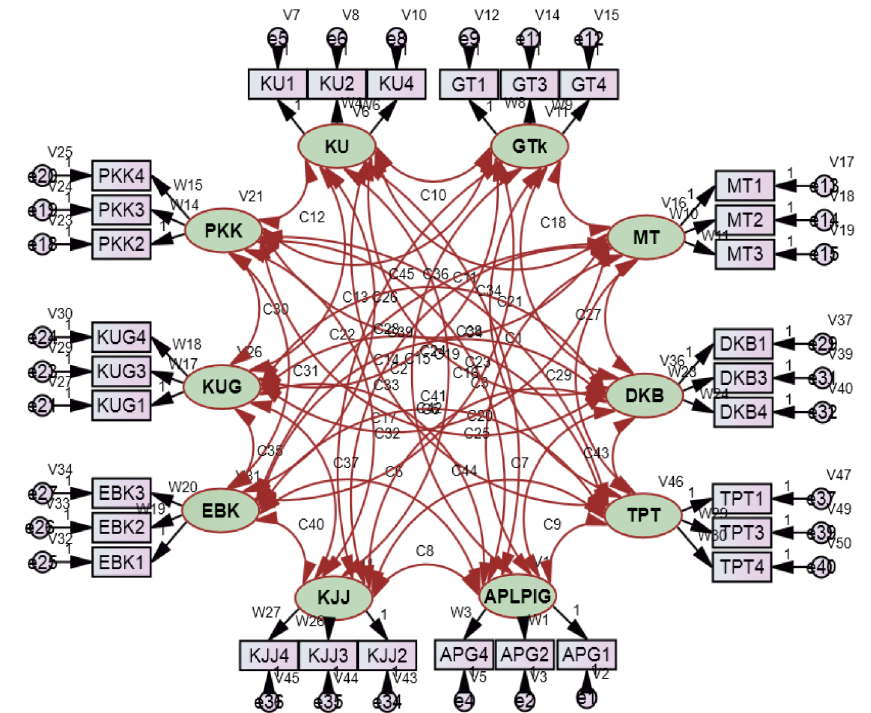
Figure 1. First-order model for measuring student competency achievement